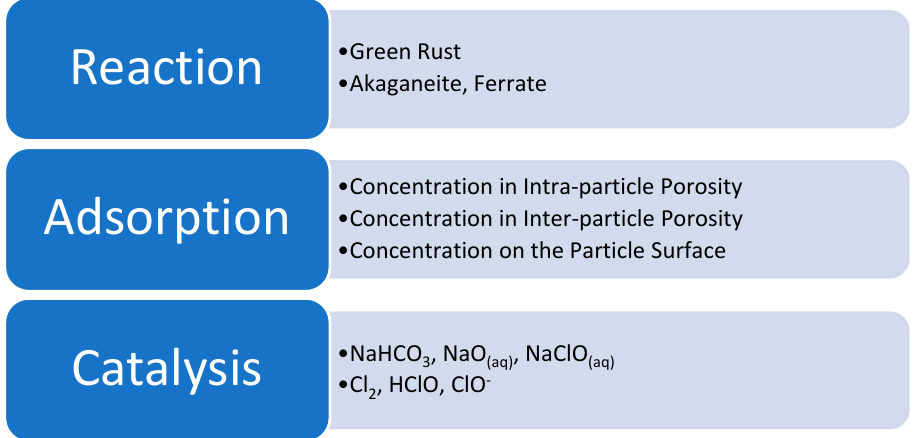
Figure 21. Desalination routes associated with ZVI.